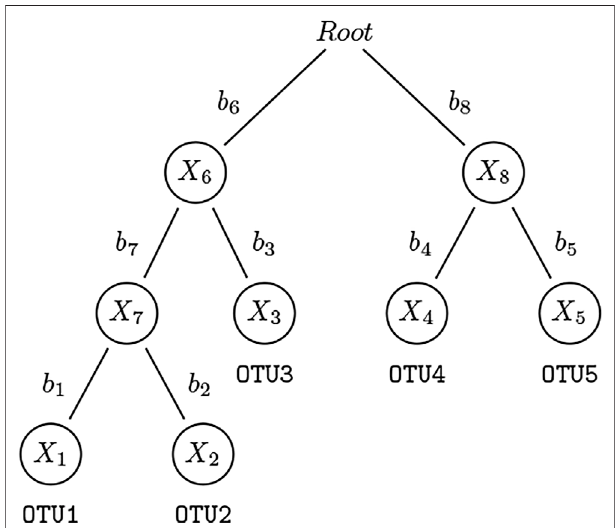
FIGURE 1 | An example of a rooted phylogenetic tree. This is a simple rooted phylogenetic tree containing 5 leaf nodes and 4 internal nodes. The counts for leaf nodes — OTU1 – 5 — can be obtained via standard pipelines. We assign the counts to internal nodes by summing up the counts of their children and refer to them also as “ OTUs ” : For three of the four abundance representations used in this paper, OTU7 = OTU1 + OTU2, OTU6 = OTU7 + OTU3, and OTU8 = OTU4 + OTU5. We construct the extended OTU matrix containing all nodes (except the root) in this phylogenetic